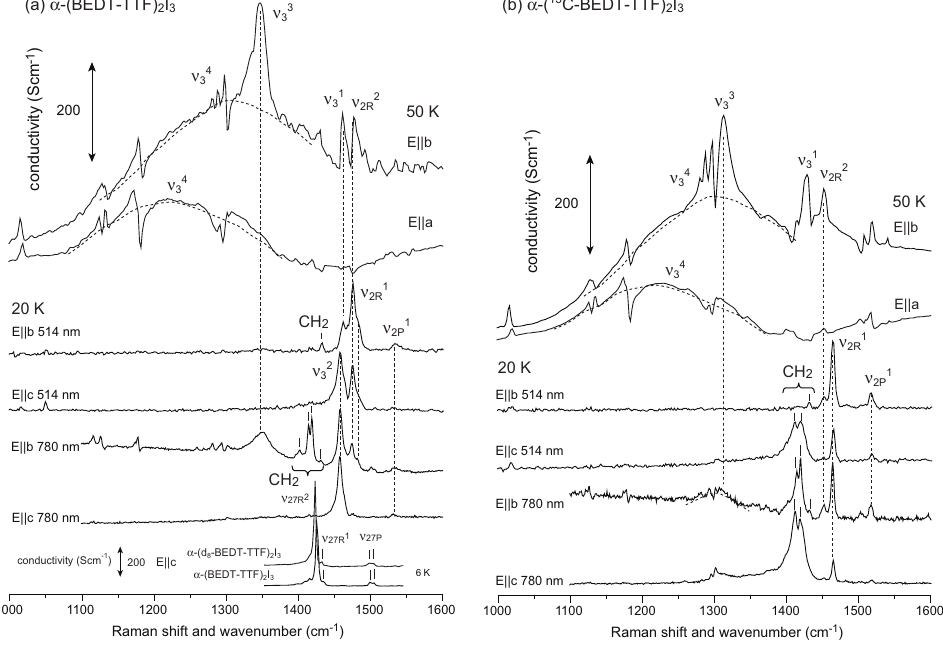
Figure 19. ( a ) Optical conductivity polarized along the b and a directions, Raman I , and optical conductivity polarized along the c direction; spectra of α -(BEDT-TTF) 2 3 ( b ) Optical conductivity polarized along the b and a directions and Raman spectra of I . α -( 13 C-BEDT-TTF) 2 3